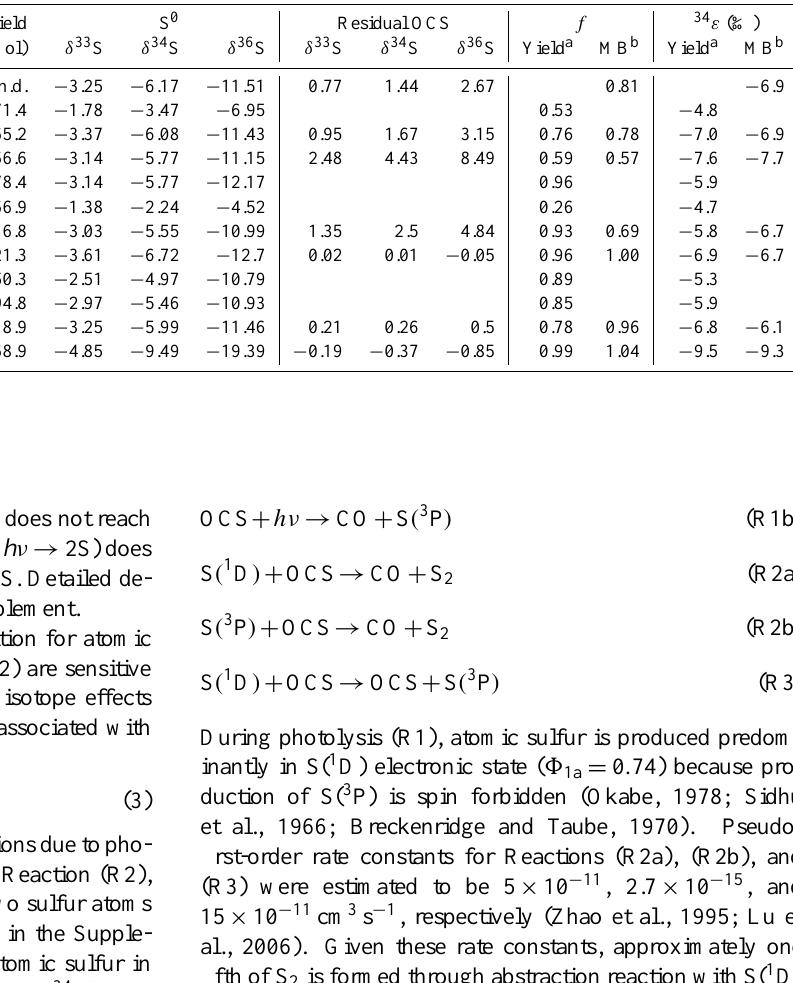
Table 1. Results for OCS photolysis experiments. Delta values are relative to initial OCS. Run-ID